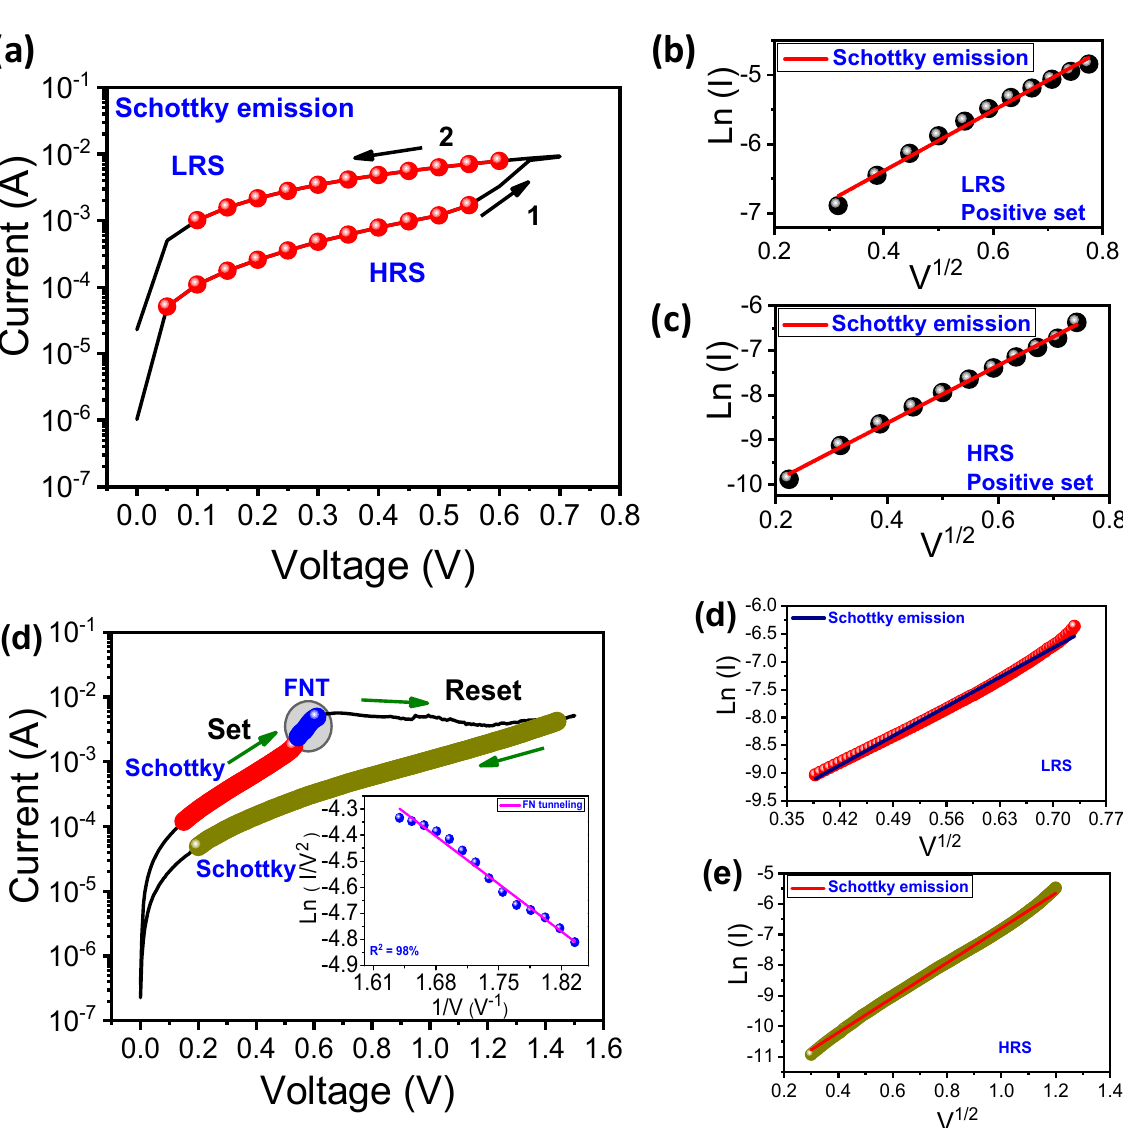
Figure 3. I–V fitting of the Pt/ZnO/TiN device for conduction mechanisms: ( a ) I–V curves for the Schottky emission in LRS and HRS for BRS; ( b , c ) Ln(I) versus V 1/2 fitting for LRS and HRS; ( d ) I–V curves in LRS and HRS for CRS; ( d , e ) Ln(I) versus V 1/2 fitting for LRS and HRS.